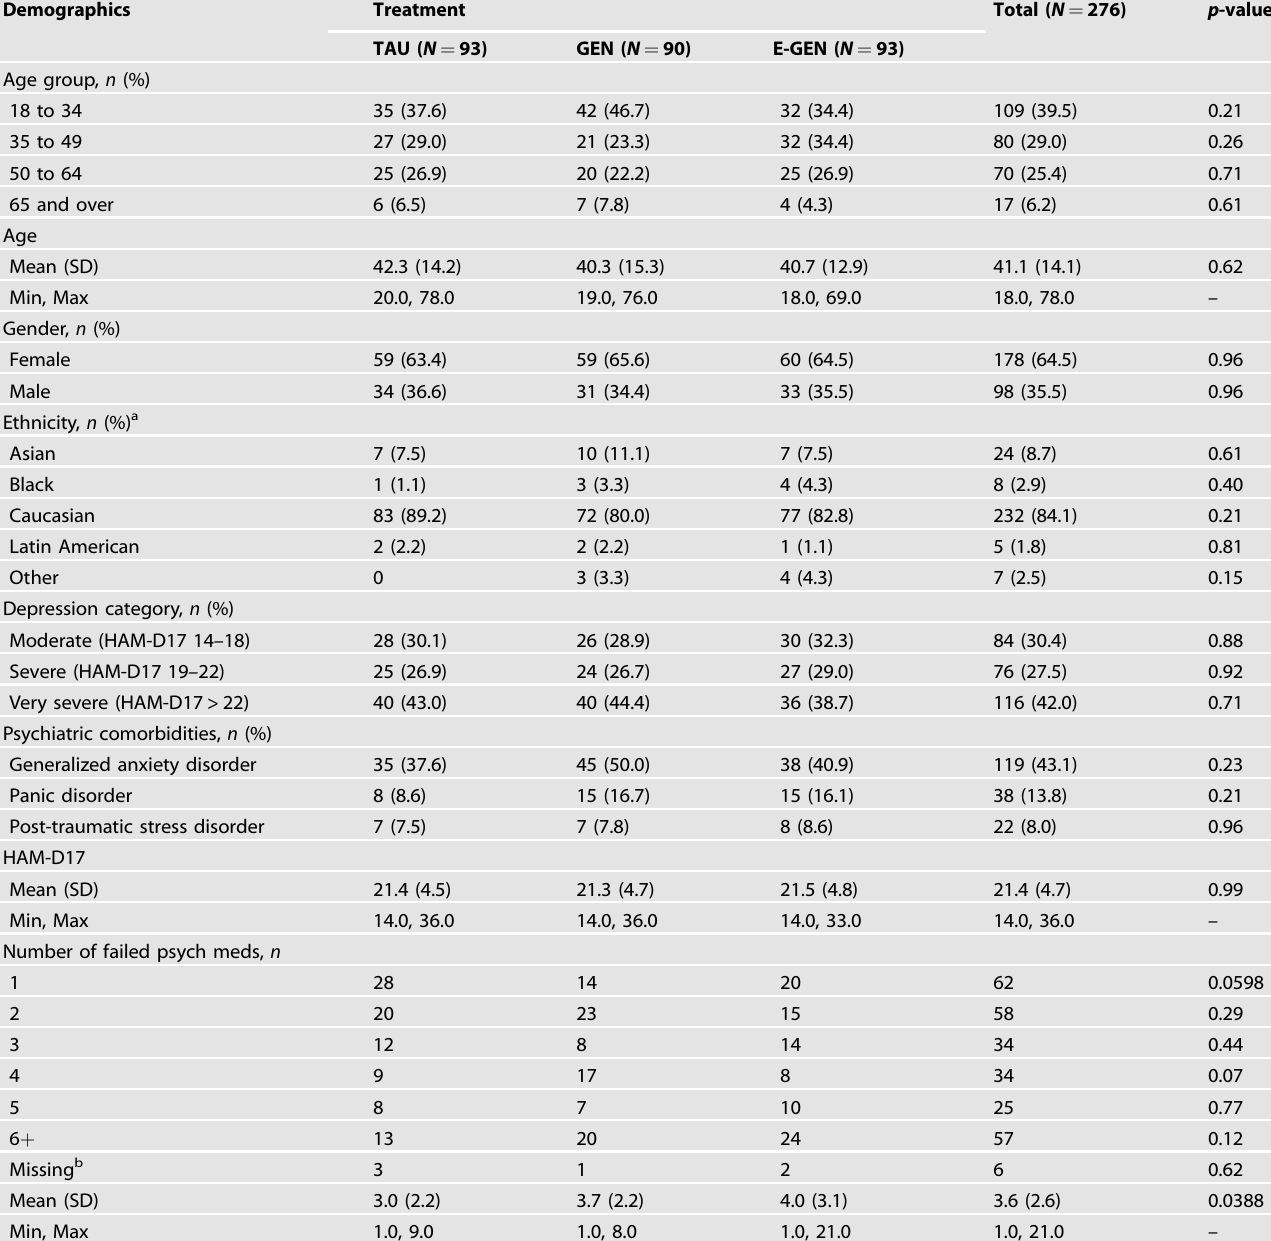
Table 1. Demographic characteristics in the GAPP-MDD clinical trial at baseline by treatment in the per-protocol